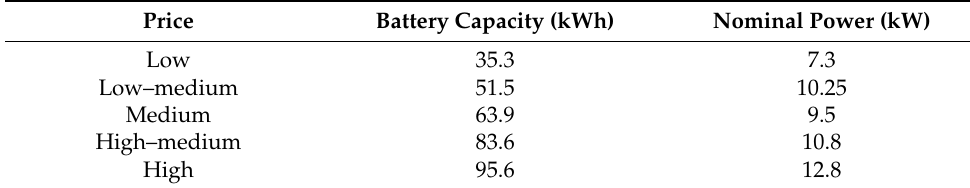
Table 2. PEV battery specifications.